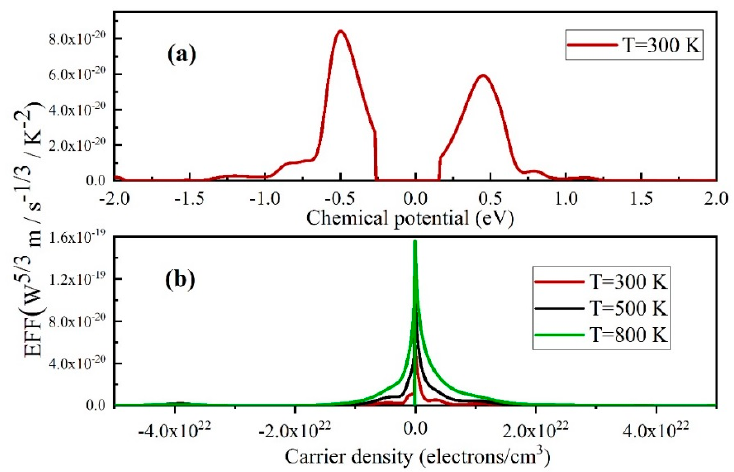
Figure 8. EFF (t) at the constant temperature versus ( a ) chemical potential. ( b ) The electrons (left) and holes (right) concentrations.